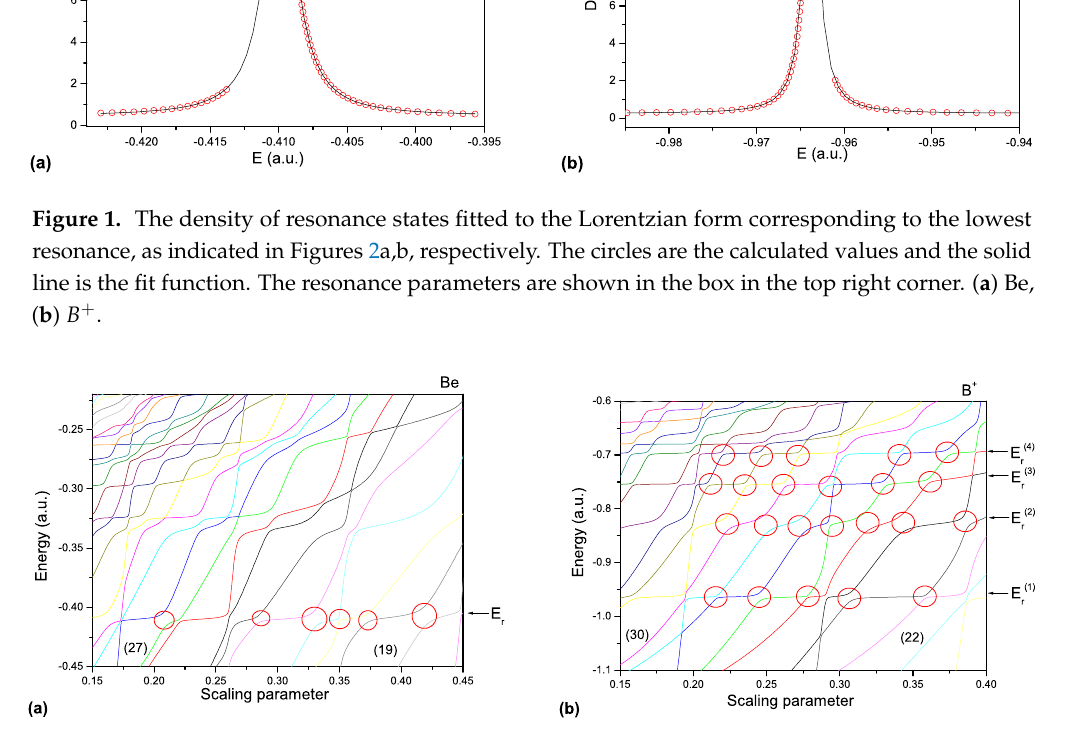
Figure 2. Stabilization diagram for λ = 0.0 obtained by considering N = 372 and giving s an increment of 0.0005 units in the wave function (7). The numbers in parenthesis left of the solid line show the order of appearance of the energy levels. The arrow indicates the position of resonance, and the circles indicate the points of avoided crossing. ( a ) Be, ( b ) B +